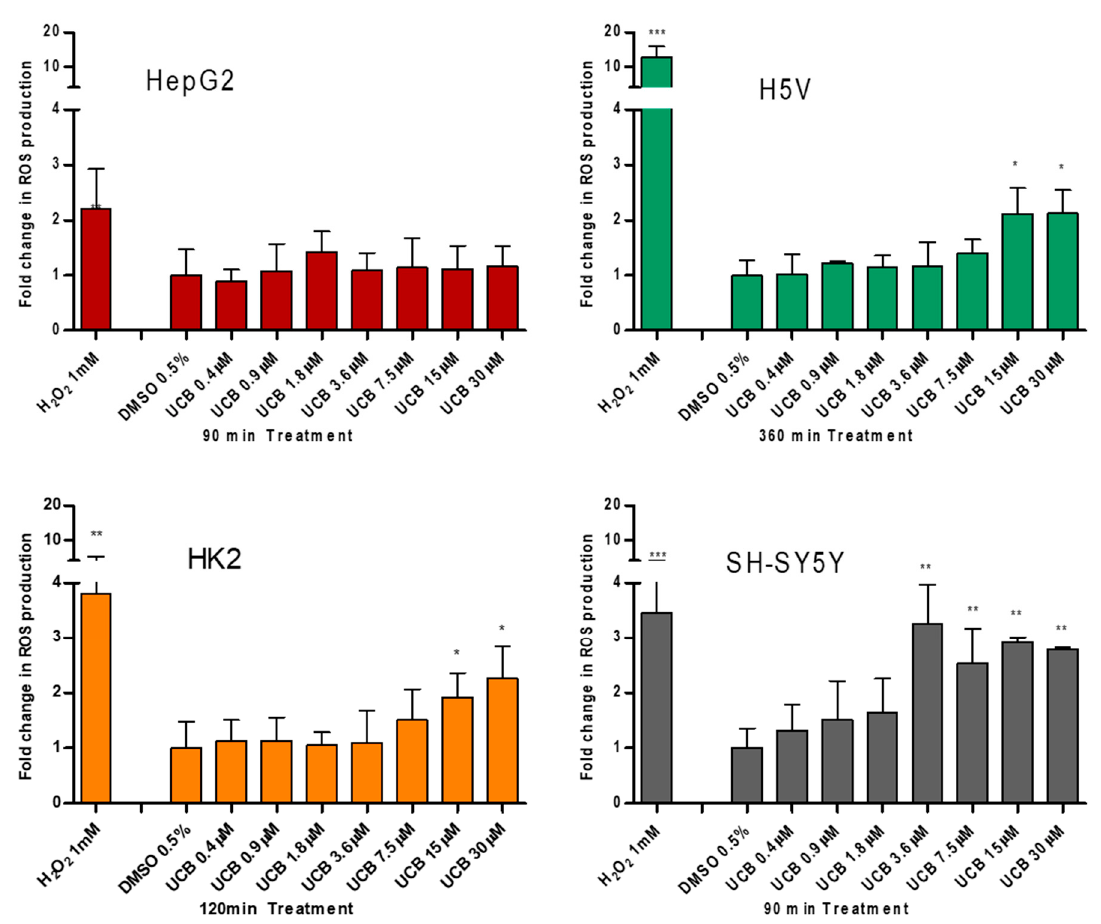
Figure 3. The e ff ect of UCB treatment on intracellular reactive oxygen species (ROS) production. The cell lines were exposed to the increasing UCB concentration (from 0.4 to 30 µ M in the presence of 30 µ M BSA) or 0.5% DMSO for the time indicated on x -axis. The time of exposure to UCB was defined based on a time course performed in each cell line. The time with the highest increase in ROS production by UCB and 1 mM H 2 O 2 (used as positive control) was selected for each cell line (90 min for HepG2 cells, 120 min for SH-SY5Y and HK2 cells, and 360 min for H5V cells). Fluorescence results reflecting ROS production were normalized to the total protein content and compared to DMSO-treated cells. Data are expressed as mean ± SD of three independent experiments. * p < 0.05, ** p < 0.01, *** p < 0.001.